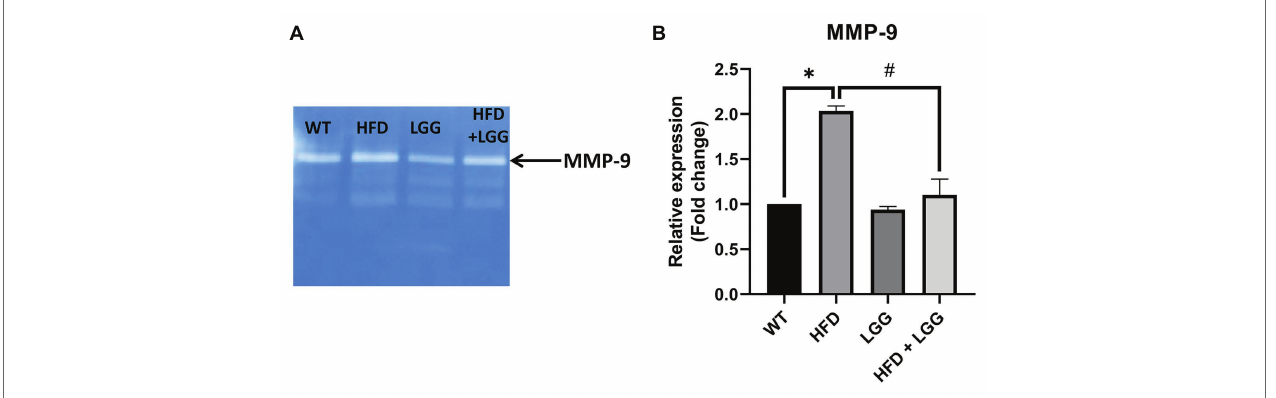
FIGURE 6 | Effect of HFD and LGG treatment on the MMP activity in periodontal tissues. WT, Wild-type C57BJ/L6 mice; HFD, HFD-supplemented wild-type mice; LGG, LGG-supplemented wild-type mice; HFD + LGG, HFD and LGG-supplemented wild-type mice. (A) Original zymography membrane. (B) Gelatin zymography